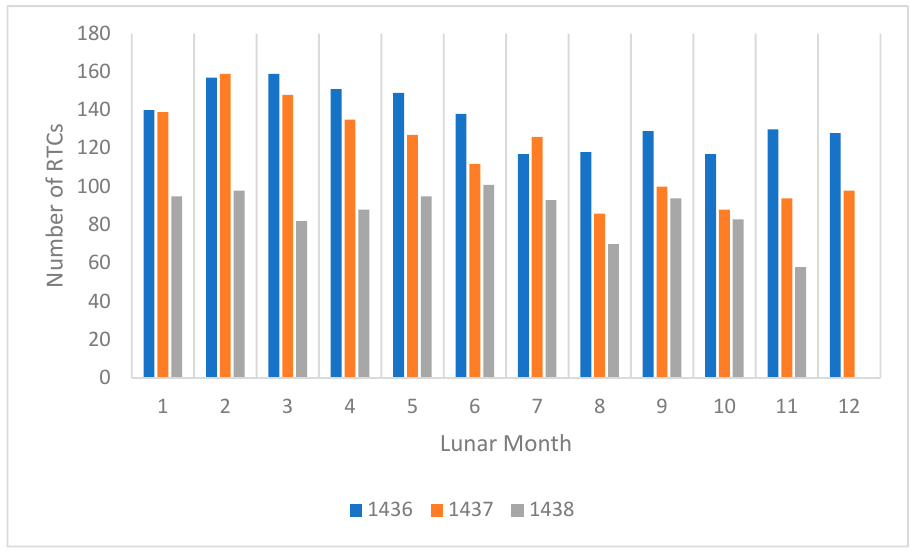
Figure 5. Month-wise distribution of fatal and severe injury traffic crashes. Table 2. ANOVA tests for lunar months.